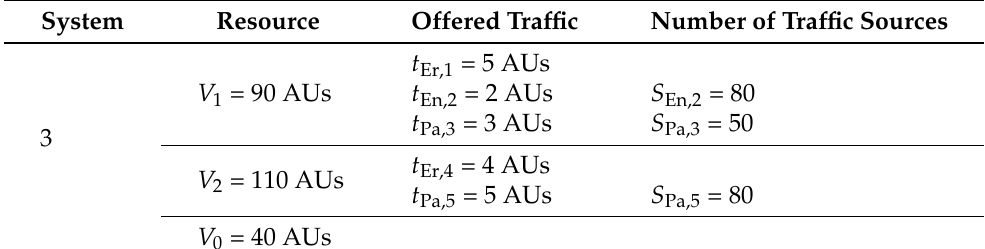
Table 2. The parameters of the multi-service systems.